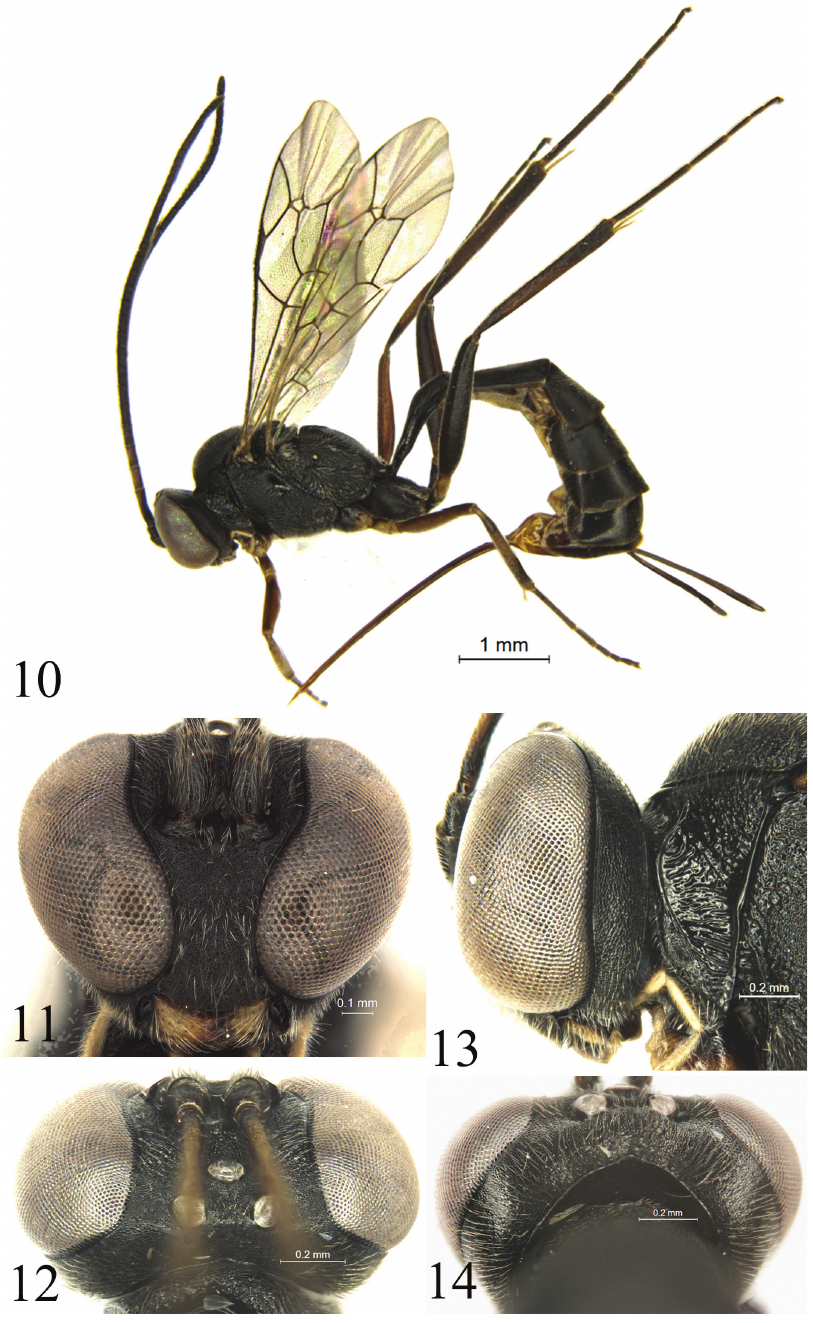
Figures 10–14. Cymodusa melana Sheng, Li & Sun, sp.nov. Holotype. Female 10 habitus, lateral view 11 head, anterior view 12 head, dorsal view 13 head and pronotum, lateral view 14 head, dorsoposterior